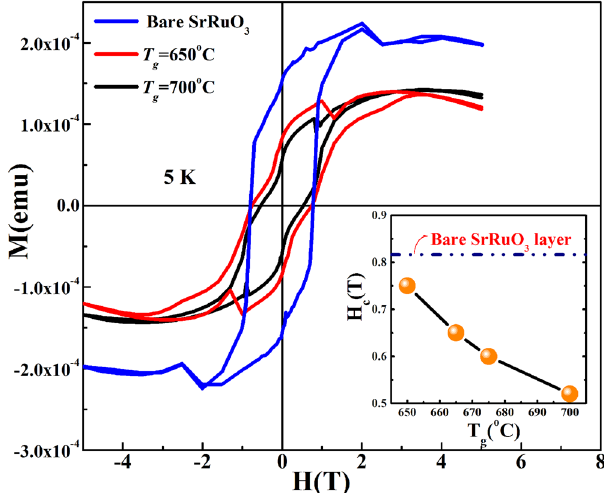
Figure 5. Low temperature magnetic properties of (BiPb)FeO 3 /SrRuO 3 /SrTiO 3 heterostructures. M – H loops measured at 5 K in out–of–plane configuration for (BiPb)FeO 3 /SrRuO 3 /SrTiO 3 heterostructures grown at T g = 650 °C and T g = 700 °C. Bare SrRuO 3 layer M – H loop is also given for comparison. Inset shows decrease in coercivity H C with T g compared to the bare SrRuO 3